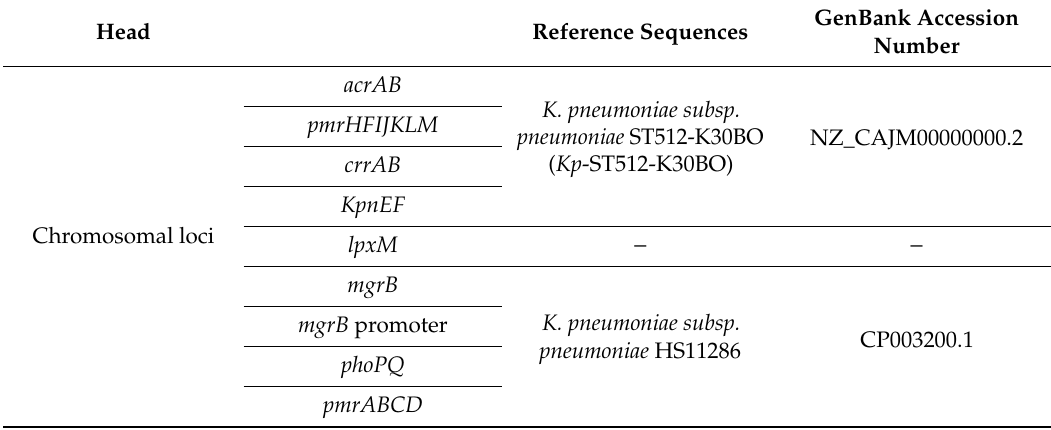
Table 4. Reference sequences used for BLAST analysis of chromosomal colistin resistance related genes. The Kp ST512-K30BO and Kp -HS11286 choice was due to their belonging to the same Clonal Complex of our isolates